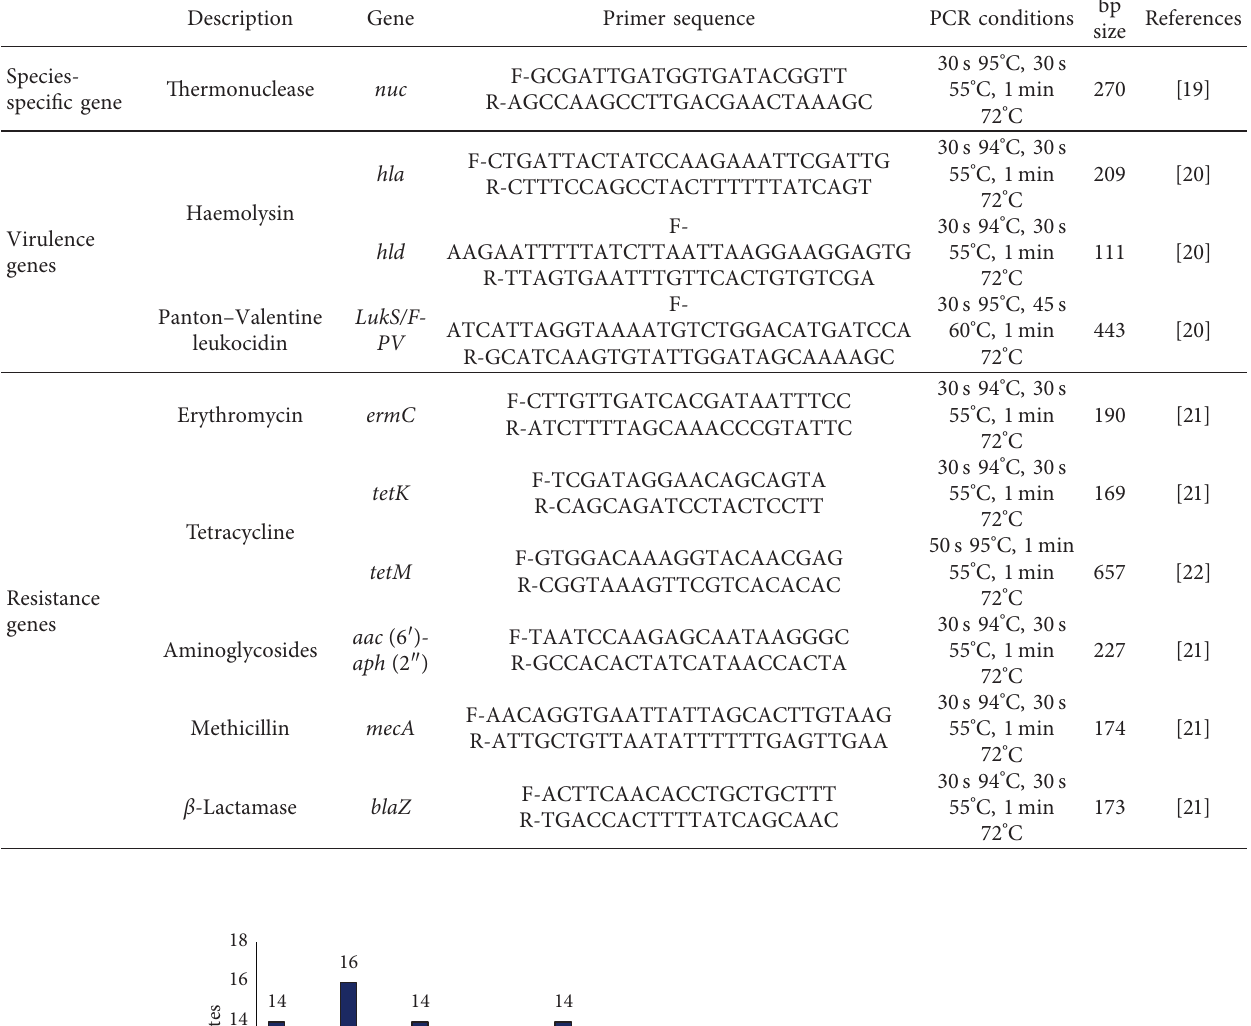
Table 1: Cycling conditions and primer sequences for genes presented in this study.